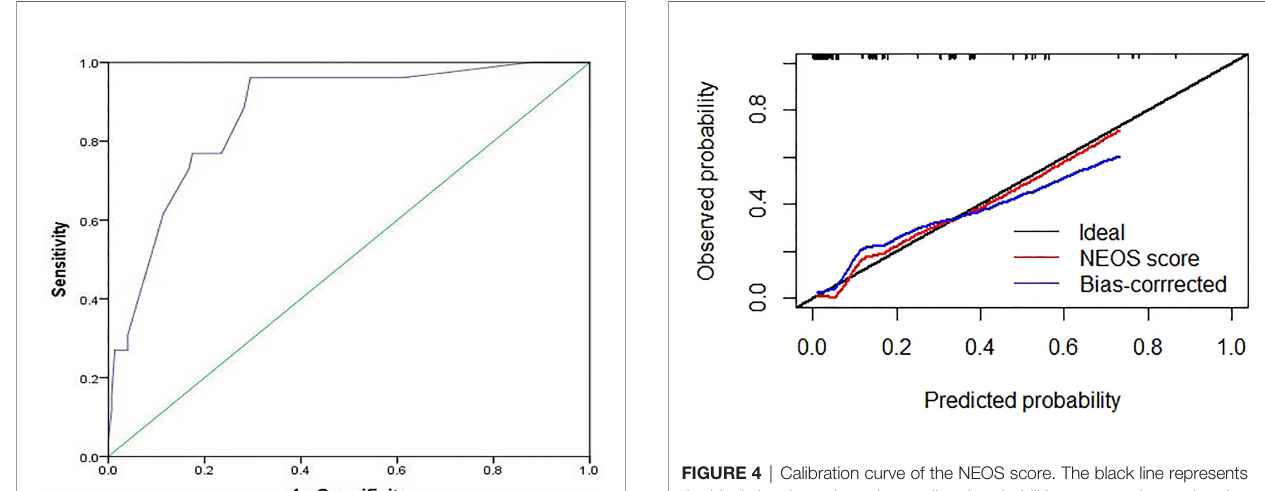
FIGURE 4 | Calibration curve of the NEOS score. The black line represents the ideal situation, where the predicted probabilities are exactly equal to the observed probabilities. The red line represents the original calibration curve of the NEOS score. The blue line represents the bias-corrected curve by R software. Both curves show good consistency with the ideal situation (black line).